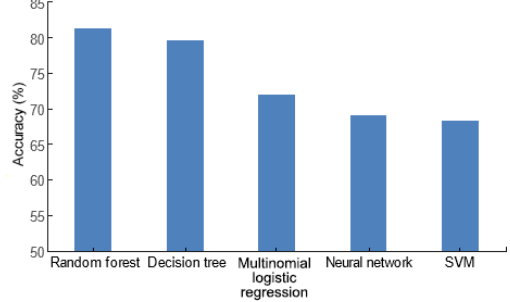
Fig. 6 Performance comparison of random forest model with other models in cured cases